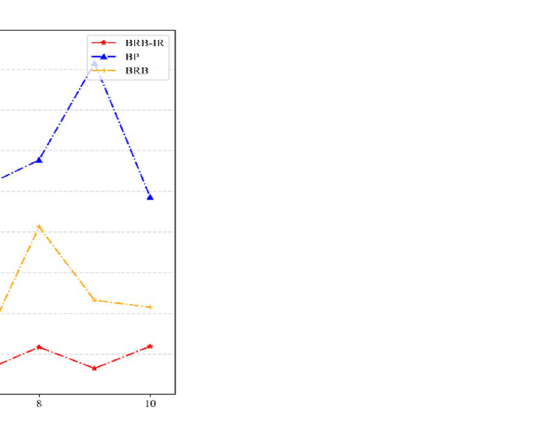
Figure 7. MSE comparison of the BRB-IR, BP, and